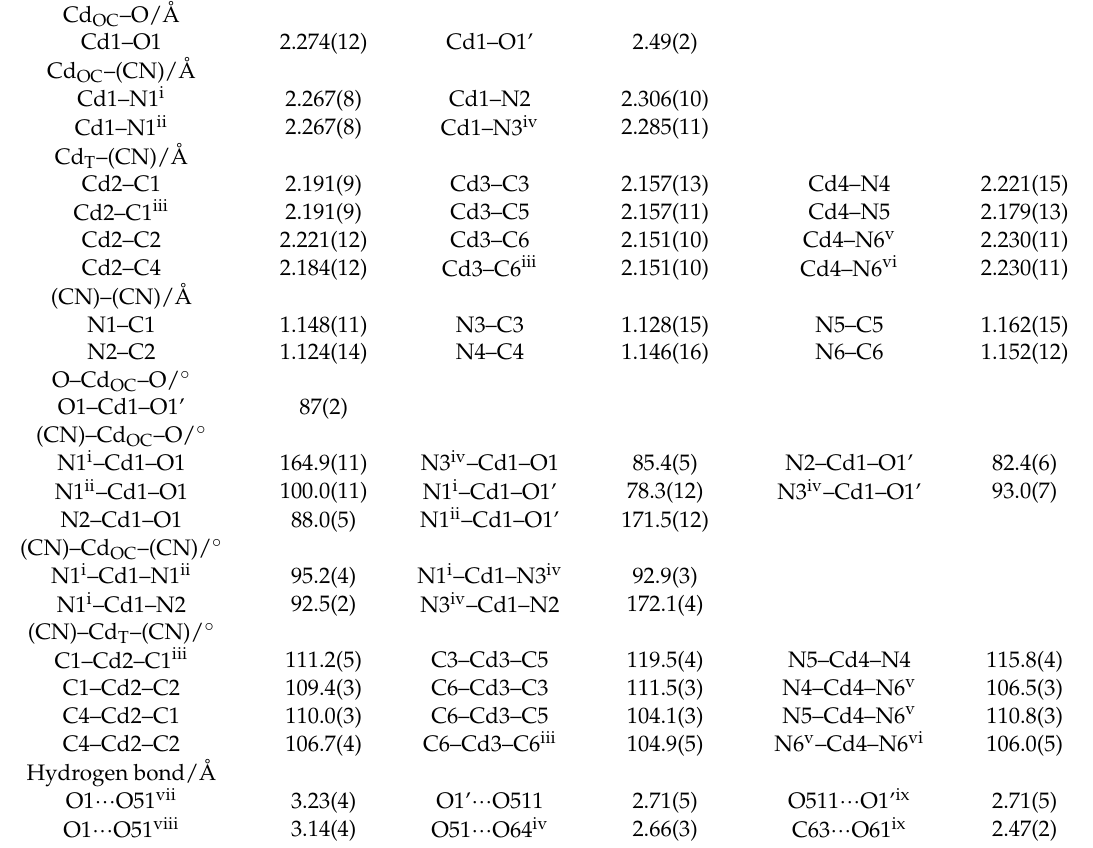
Table 4. Selected Parameters for III